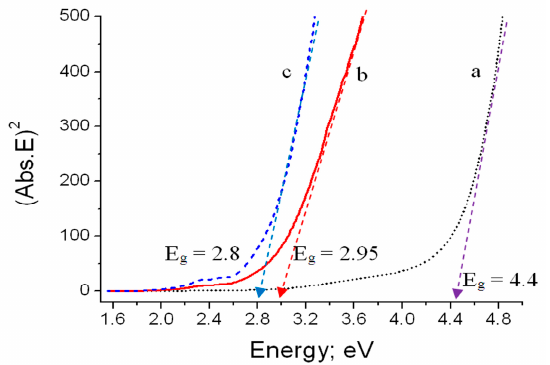
Figure 12. Band gap energy of Co–Si LDHs: ( a ) pure, ( b ) after zirconium inclusion, and ( c ) after zirconium and titanium inclusion.